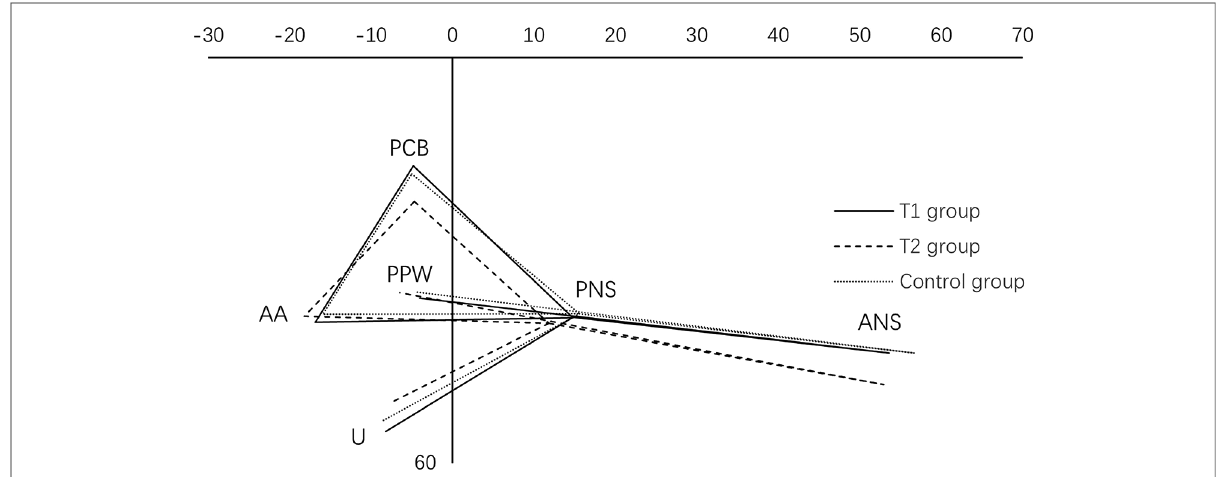
FIGURE 2 Velopharyngeal morphology of three groups. ANS, anterior nasal spine; PNS, posterior nasal spine; PPW, posterior pharyngeal wall; N, nasion; S, center of the sella turcica; PCB, pterygoid cranial base; AA, atlas; U, uvula, tip of the uvula when at rest.